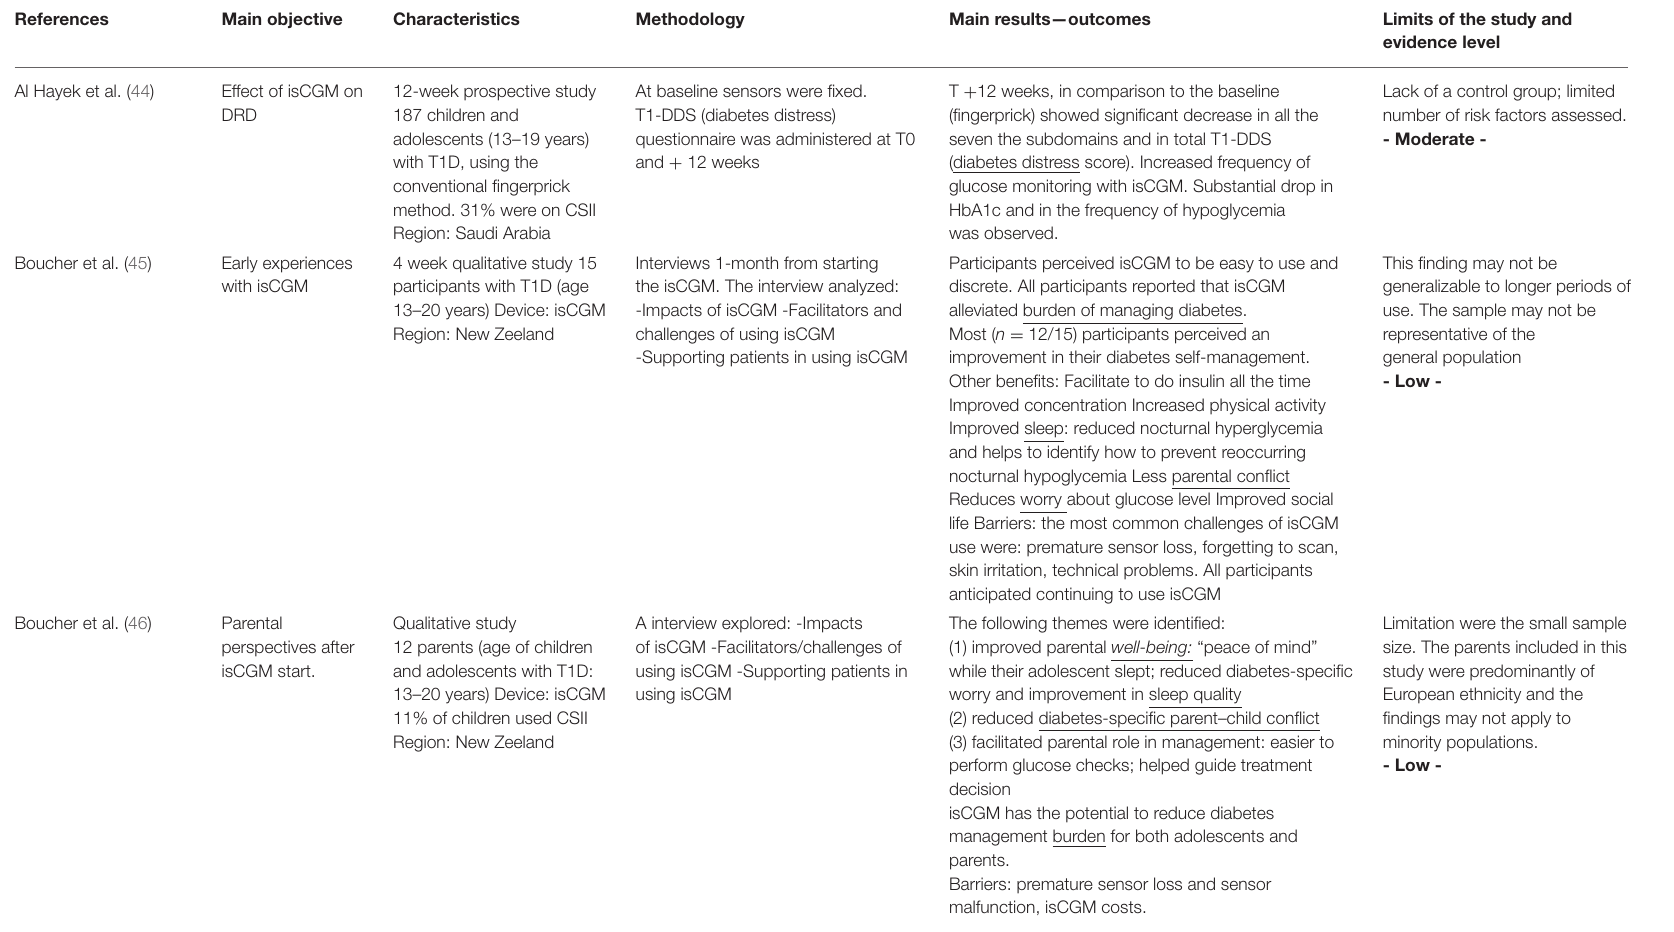
TABLE 2 | Analysis of the 25 papers included in the systematic